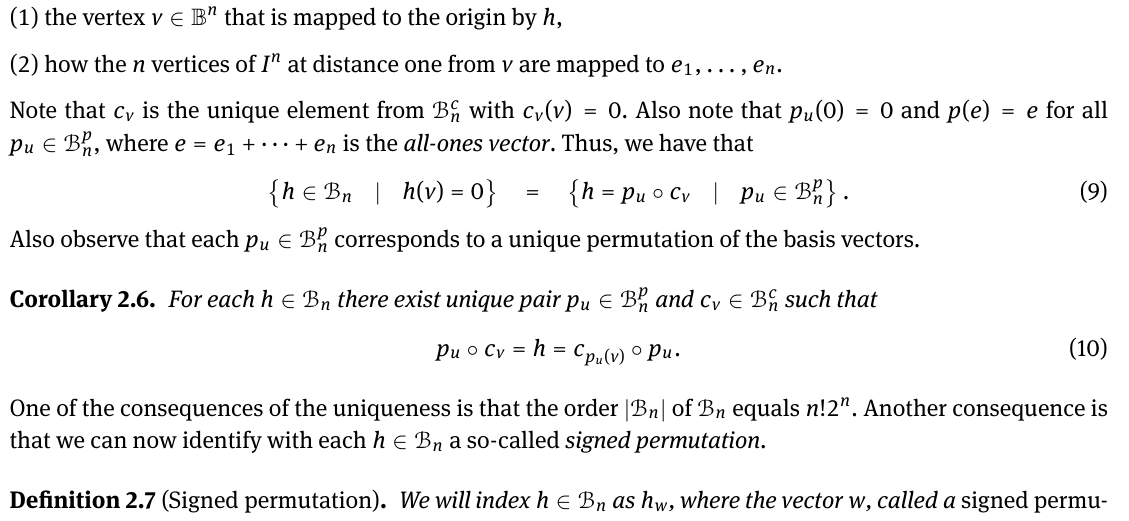
B c acts on I 3 as depicted in the right part of Figure w ∈ n